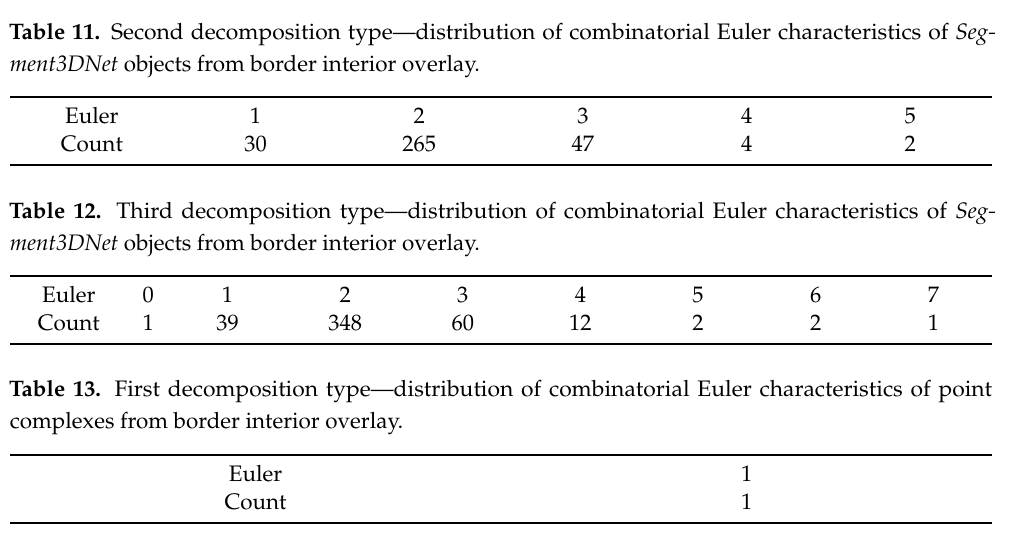
Table 14. Second decomposition type—distribution of combinatorial Euler characteristics of point complexes from border interior overlay. Euler